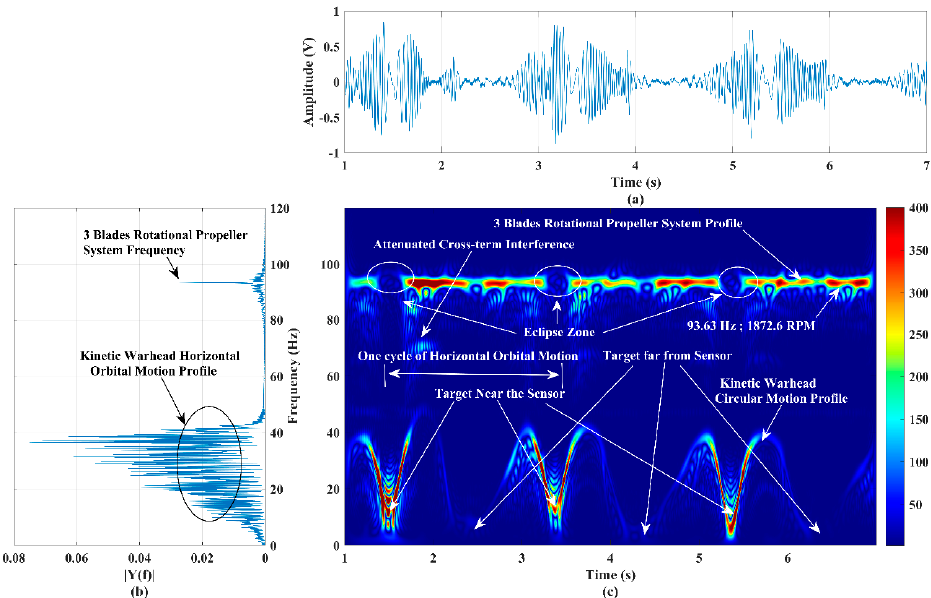
Figure 9. ( a ) Time − series plot, ( b ) power spectrum plot, and ( c ) micro − Doppler signature/pattern image designed using the improved SP − WVD for the simultaneous activities of two targets: a three − blade rotational propeller system and a circular horizontal path kinetic warhead’s orbital motion. These signatures clearly confirm the simultaneous behavioral detection of low RCS aerial targets having rotational and non-rotational parts. However, when the kinetic war- head appears close to the radar in the boresight axis, it completely blocks the echo power of the rotational propeller system target due to the target’s size difference.